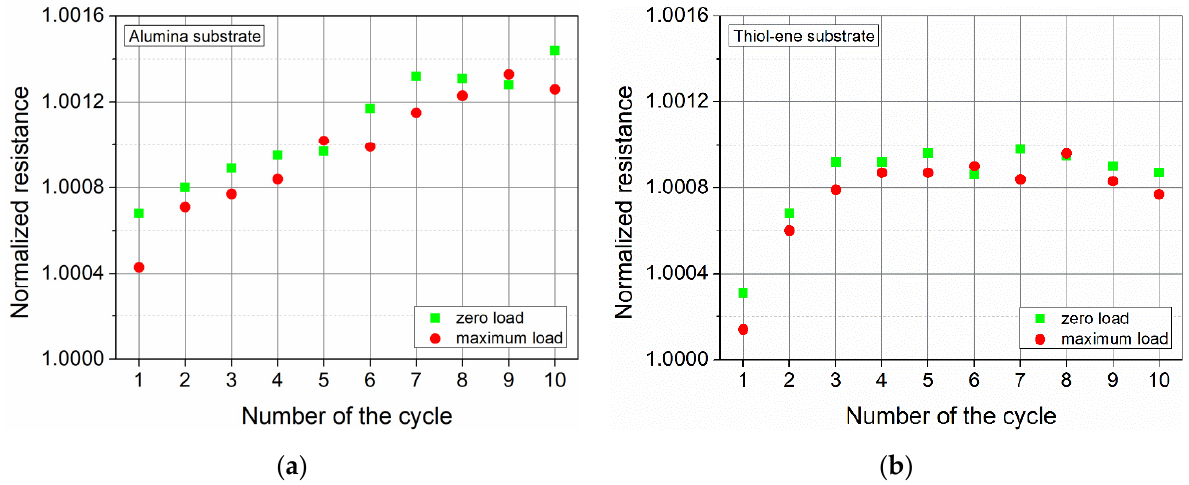
Figure 11. Normalized resistance of the PEDOT:PSS films at zero and maximum load versus the number of load–unload cycles: ( a ) alumina substrate and ( b ) thiol–ene substrate on alumina.